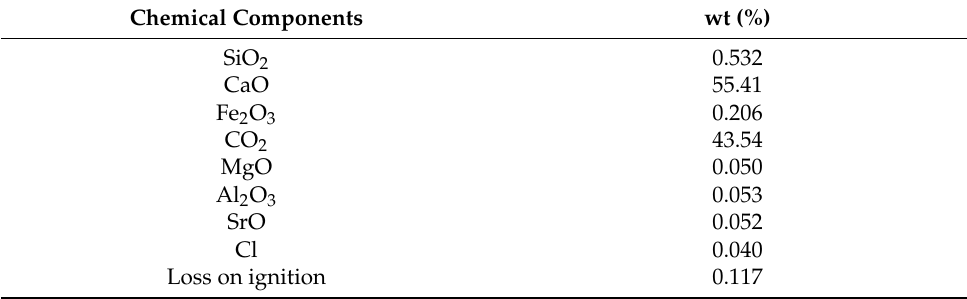
Table 2. Main chemical composition content of the rock sample and LS